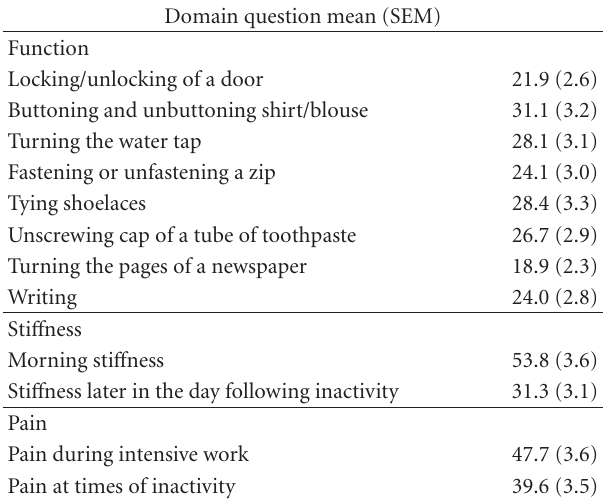
Table 2: Items and results of the M-SACRAH. (Identical questions in both questionnaires are given in